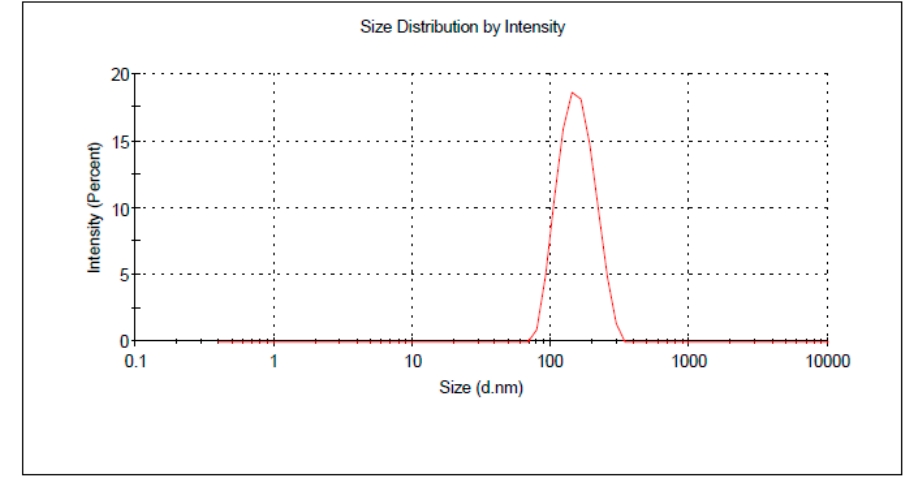
Figure 4. Particle size distribution of the optimized formulation.